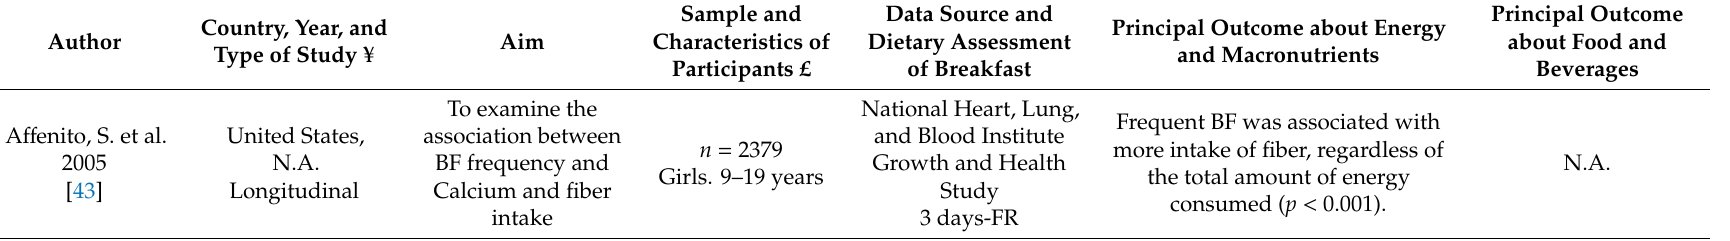
Table 3. Characteristics, description, and summary of outcomes of studies included in the system review on breakfast and energy, macronutrients, and food